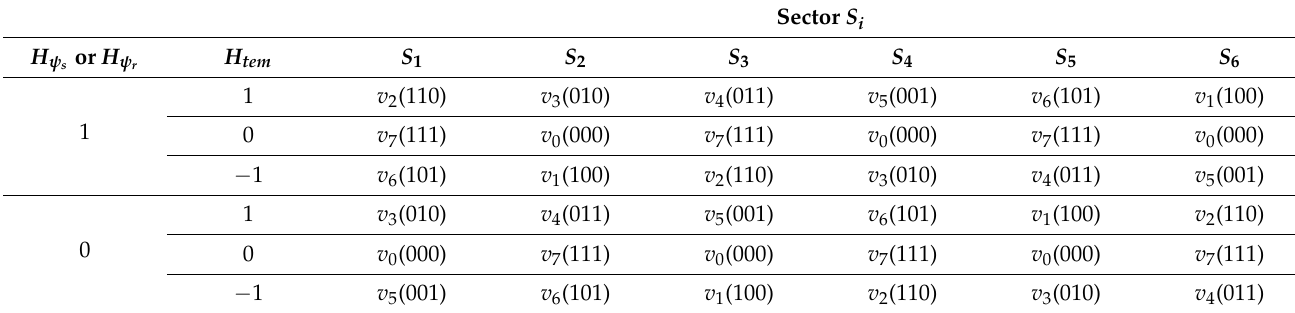
Table 1. The sequences of inverters.